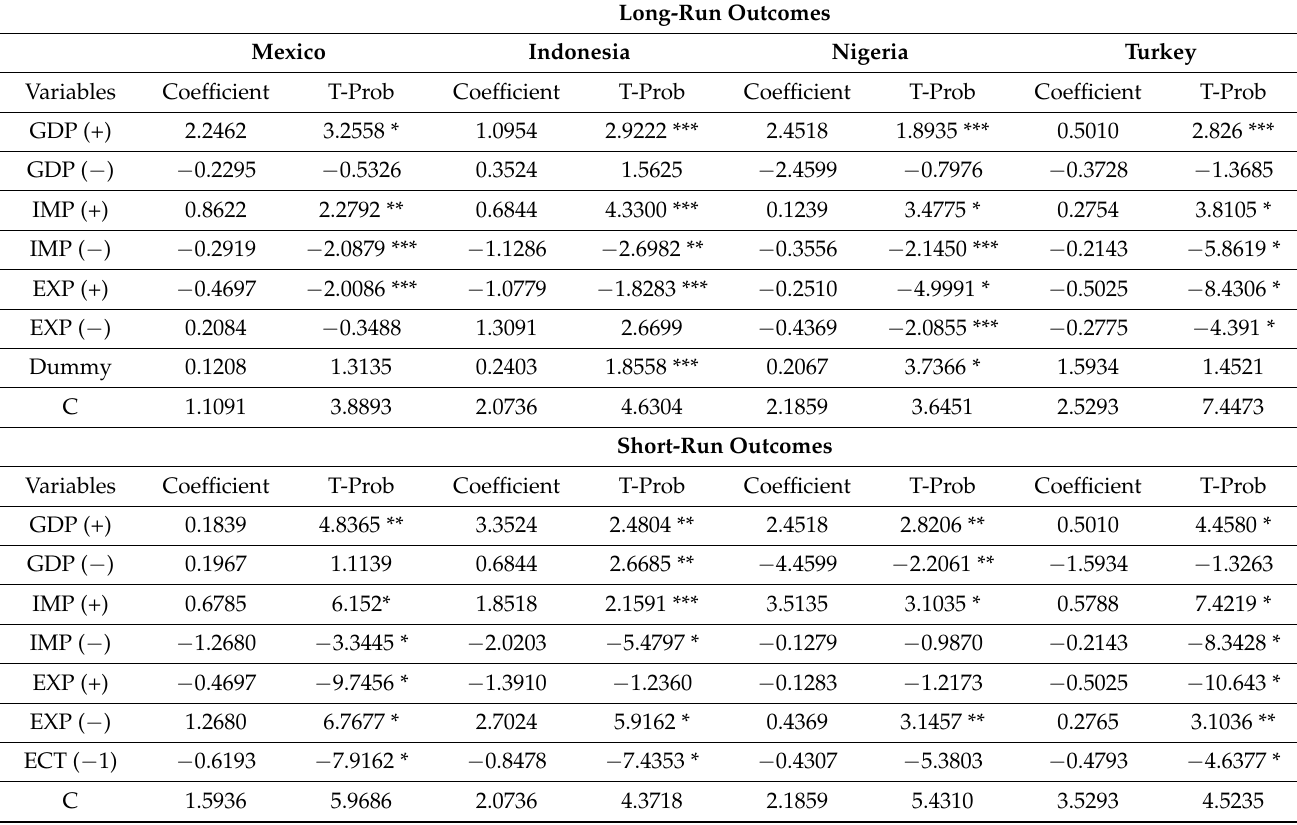
Table 6. NARDL Long- and Short-Run